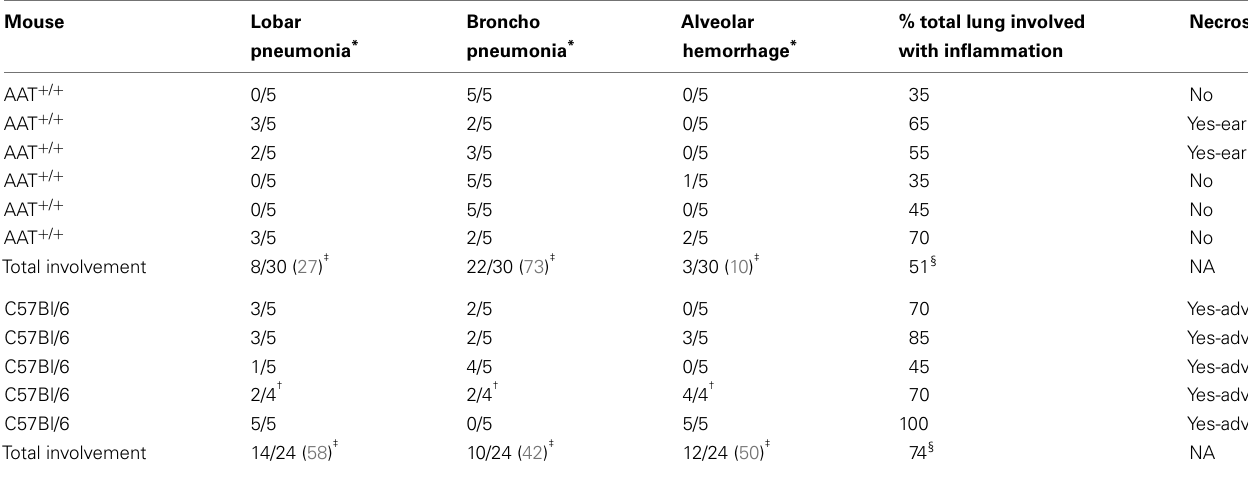
Table 1 | Lung histopathology in sixAAT + / + and five C57Bl/6 control mice infected with P.aer